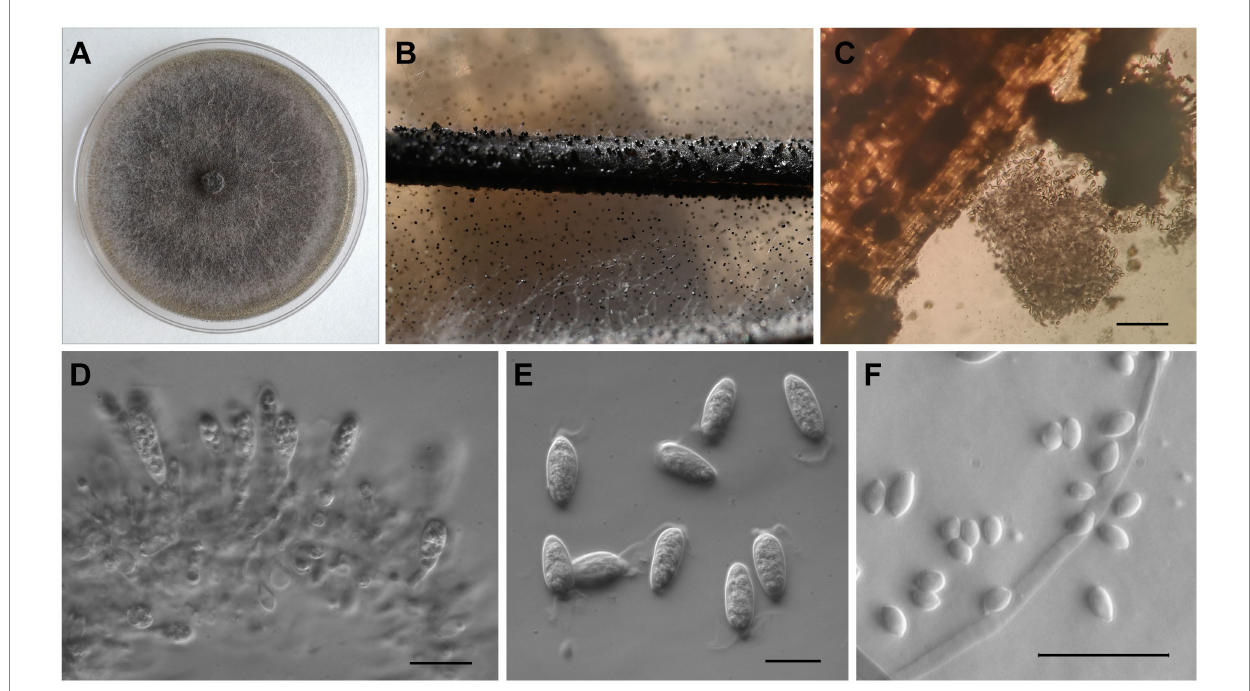
FIGURE 4 Morphological characteristics of Macrophomina phaseolina isolated from sugar beet in Serbia. (A) Colony on PDA; (B) Sclerotia and conidiomata on PNA; (C) Conidiomata and conidia; (D) Conidiogenous cells; (E) Conidia with apical appendages; and (F) Microconidia. In (C) scale bar = 200 μ m, while in (D–F) scale bar = 20 μ